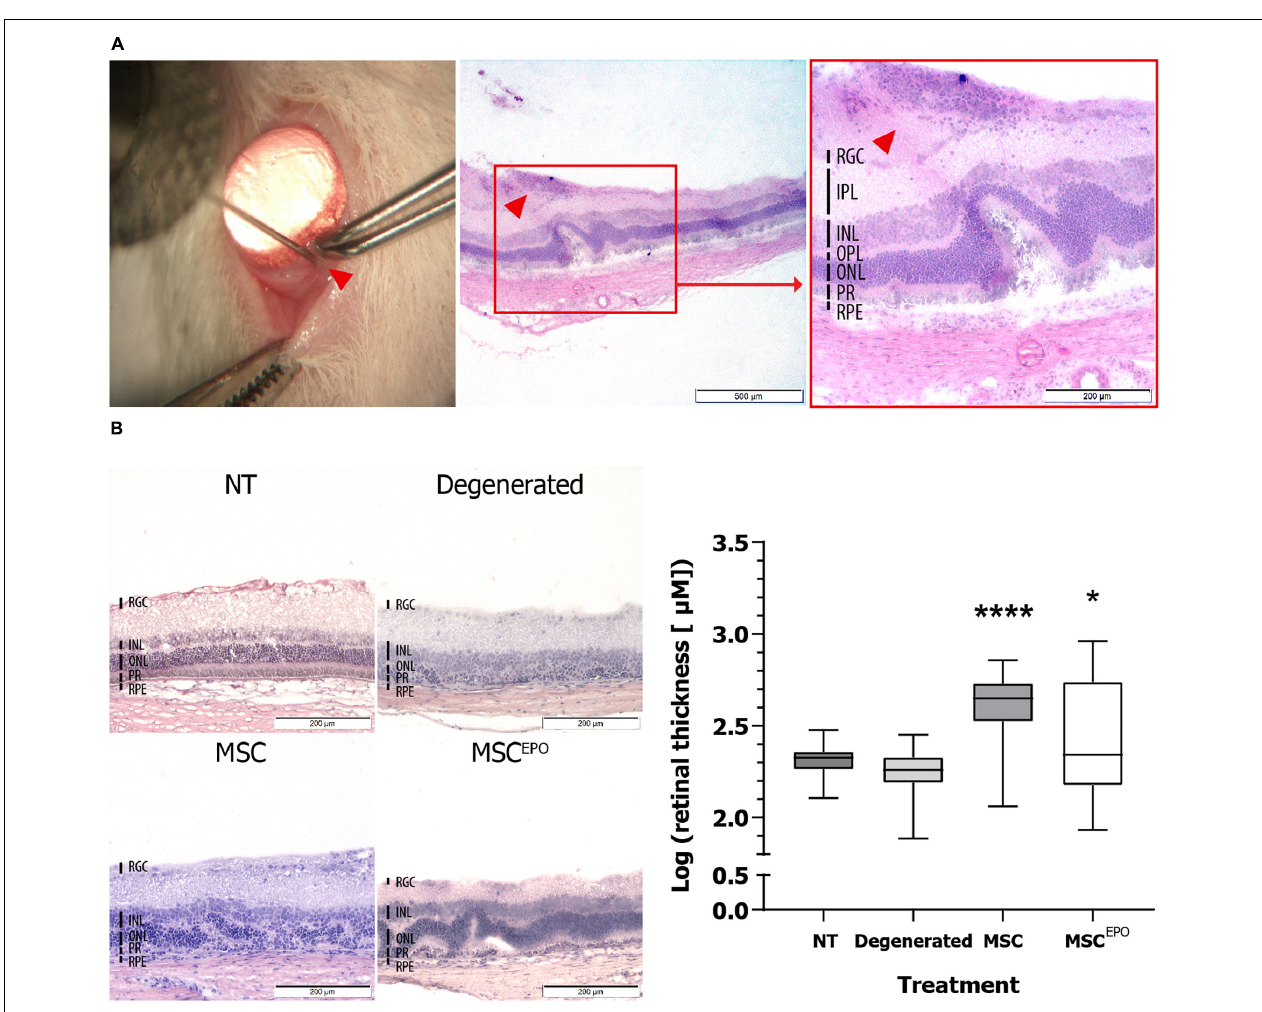
FIGURE 1 | Ocular histology of normal, degenerated MSC, and MSC EPO -treated rats at day 31. (A) On day 31 post-operation, MSC EPO transplanted sections were stained with H&E and a population of cells was found on the RGC layer. The sections were viewed under 40 × and 100 × total magnification. The scale bars denoted 500 and 200 µ m, respectively. The indicator points to the site of injection. (B) By comparing the sections, thicker retinas were found in the stem cell-treated groups. The sections were viewed under 100 × total magnification. The scale bars were denoted as 200 µ m. The results were presented as mean ± SEM. P values were obtained using one-way ANOVA and Dunnett’s multiple comparisons test post-hoc (* P < 0.05, **** P < 0.001). NT, no-treatment control; Degenerated, NaIO 3 -only/vehicle control; RPE, retinal pigment epithelium; PR, rods and cons layer; ONL, outer nuclear layer; OPL, outer plexiform layer; INL, inner nuclear layer; IPL, inner plexiform layer; RGC, retinal ganglion cells.